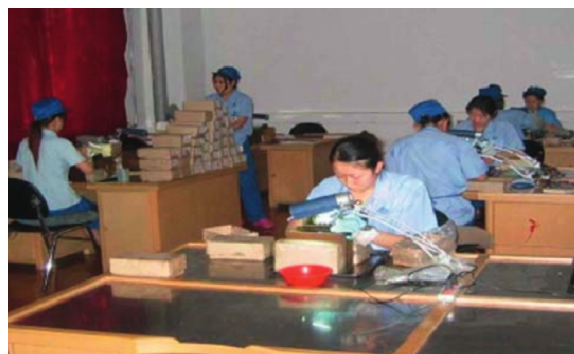
Figure 1: Manual sampling inspection of